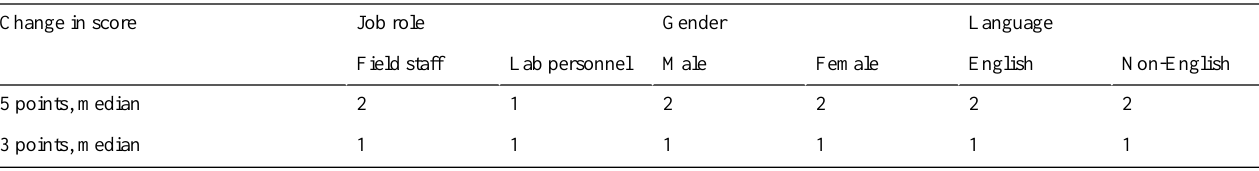
Table 2. Change in assessment scores by demographics.